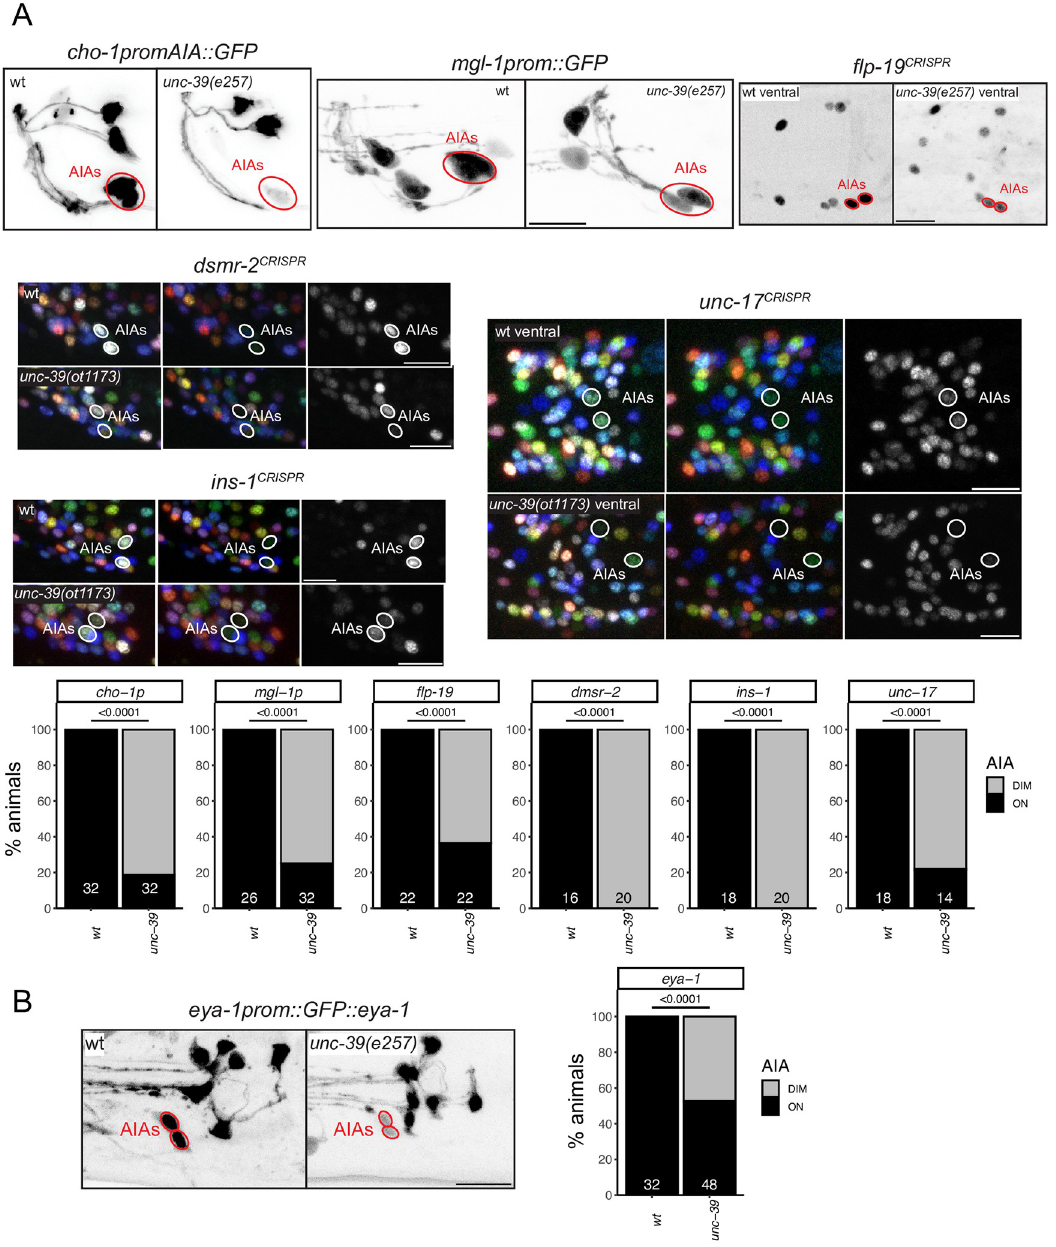
Fig 2. unc-39 controls differentiation of the AIA interneuron class. unc-39 R203Q mutant animals (either canonical e257 allele or CRISPR/Cas9 genome engineered ot1173 allele with identical nucleotide change) were analyzed. Fig 2A: unc-39 affects the cholinergic identity of the AIA interneuron class ( unc-17 reporter allele syb4491 and a cho-1 promoter fragment which is part of the otIs653 array), and other AIA terminal identity markers: reporter alleles dmsr-2(syb4514) , ins-1(syb5452) and flp-19(syb3278) , and a mgl-1 promoter fragment otIs327 . We did not quantify changes in AIA in the NeuroPAL color code, because it is variable in wild type. Representative images of wild type and mutant worms are shown with 10 μ m scale bars. Graphs compare expression in wild type and mutant worms with the number of neurons examined listed at the bottom of the bar. P-values were calculated by Fisher’s exact test. Fig 2B: unc-39 affects the expression of the tagged eya-1 locus ( nIs352 transgene) in AIA.